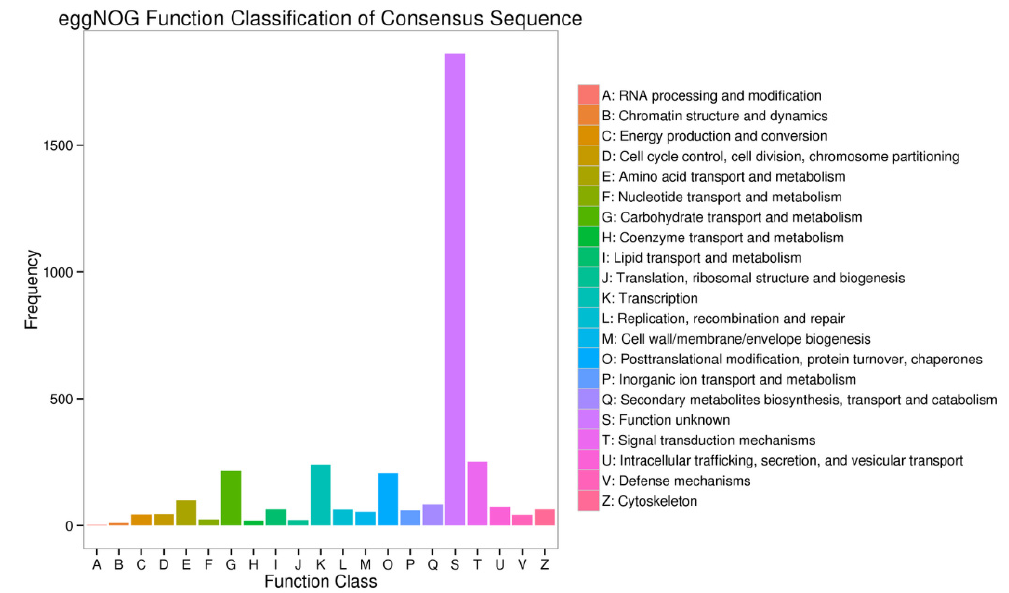
Figure 4. eggNOG annotation of the xylem DEGs in S1 vs. S2 from the “Shanxin”